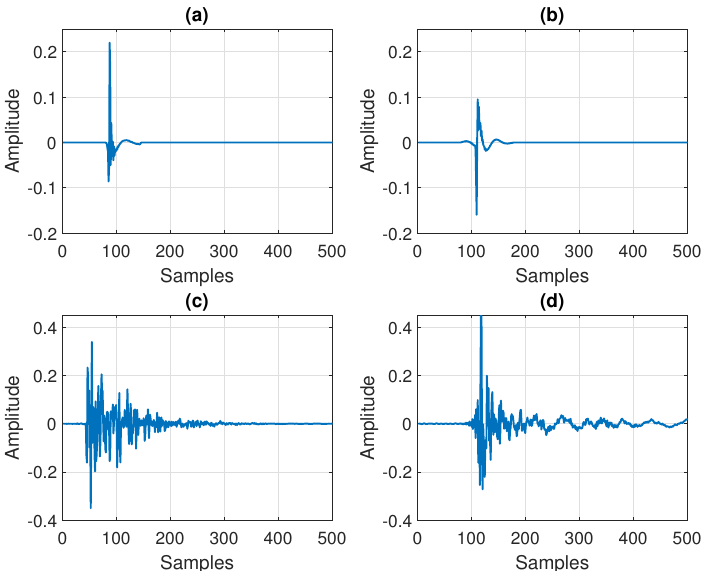
Figure 1. Impulse responses used in simulations, with L = 500: ( a , b ) network echo paths from the ITU-T G168 Recommendation [42]; ( c , d ) acoustic echo